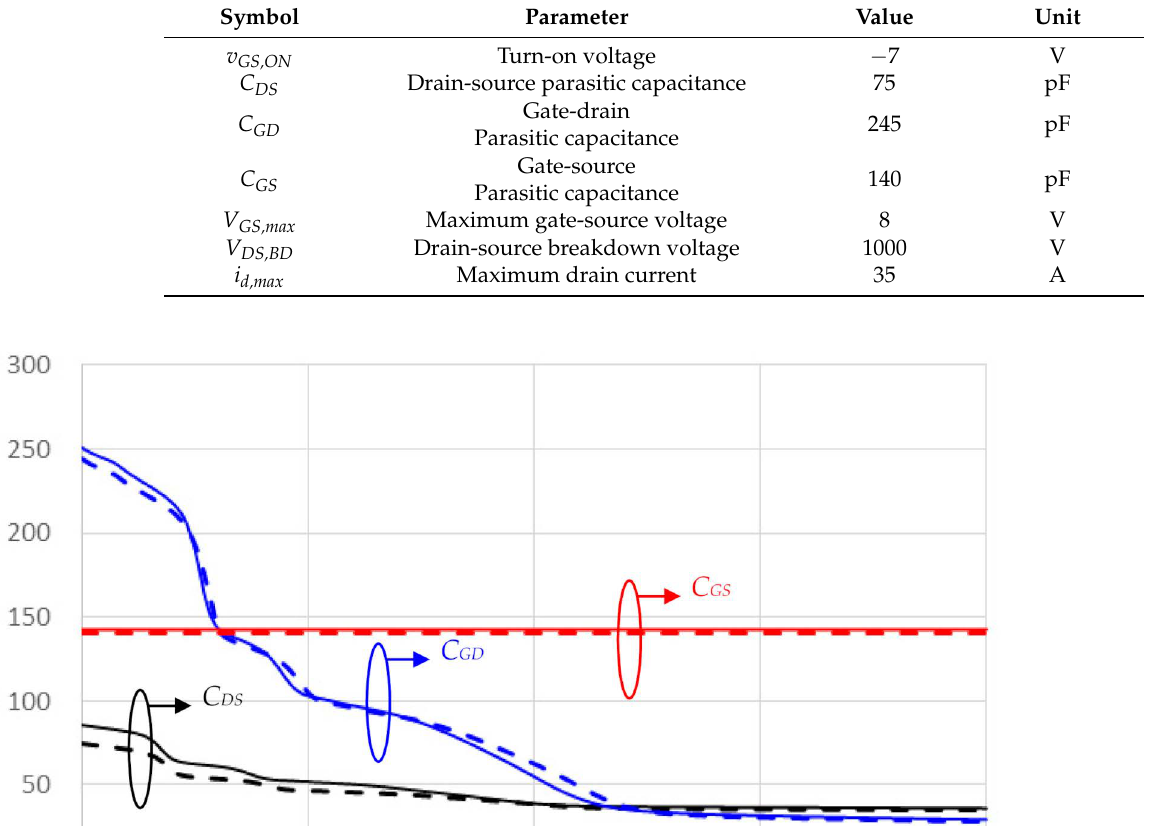
Table 3. Characteristic summary of the D-mode GaN HEMT.